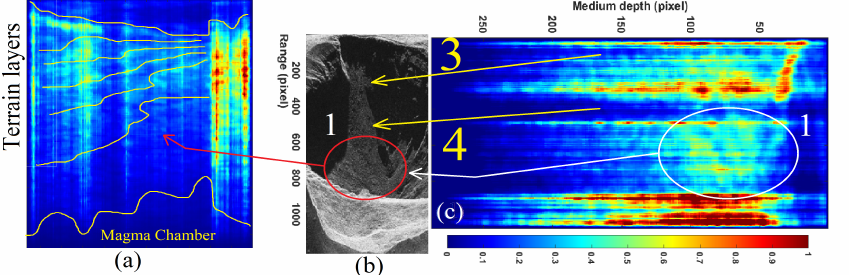
Figure 9. Range-line echographic tomography result (magnitude). ( a ) Tomographic result (in magni- tude). ( b ) SLC SAR image (in magnitude). ( c ) Tomographic result (in magnitude).